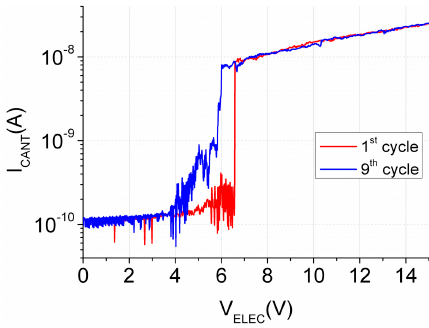
Figure 5. Switch electrical characterization in different successive cycles.